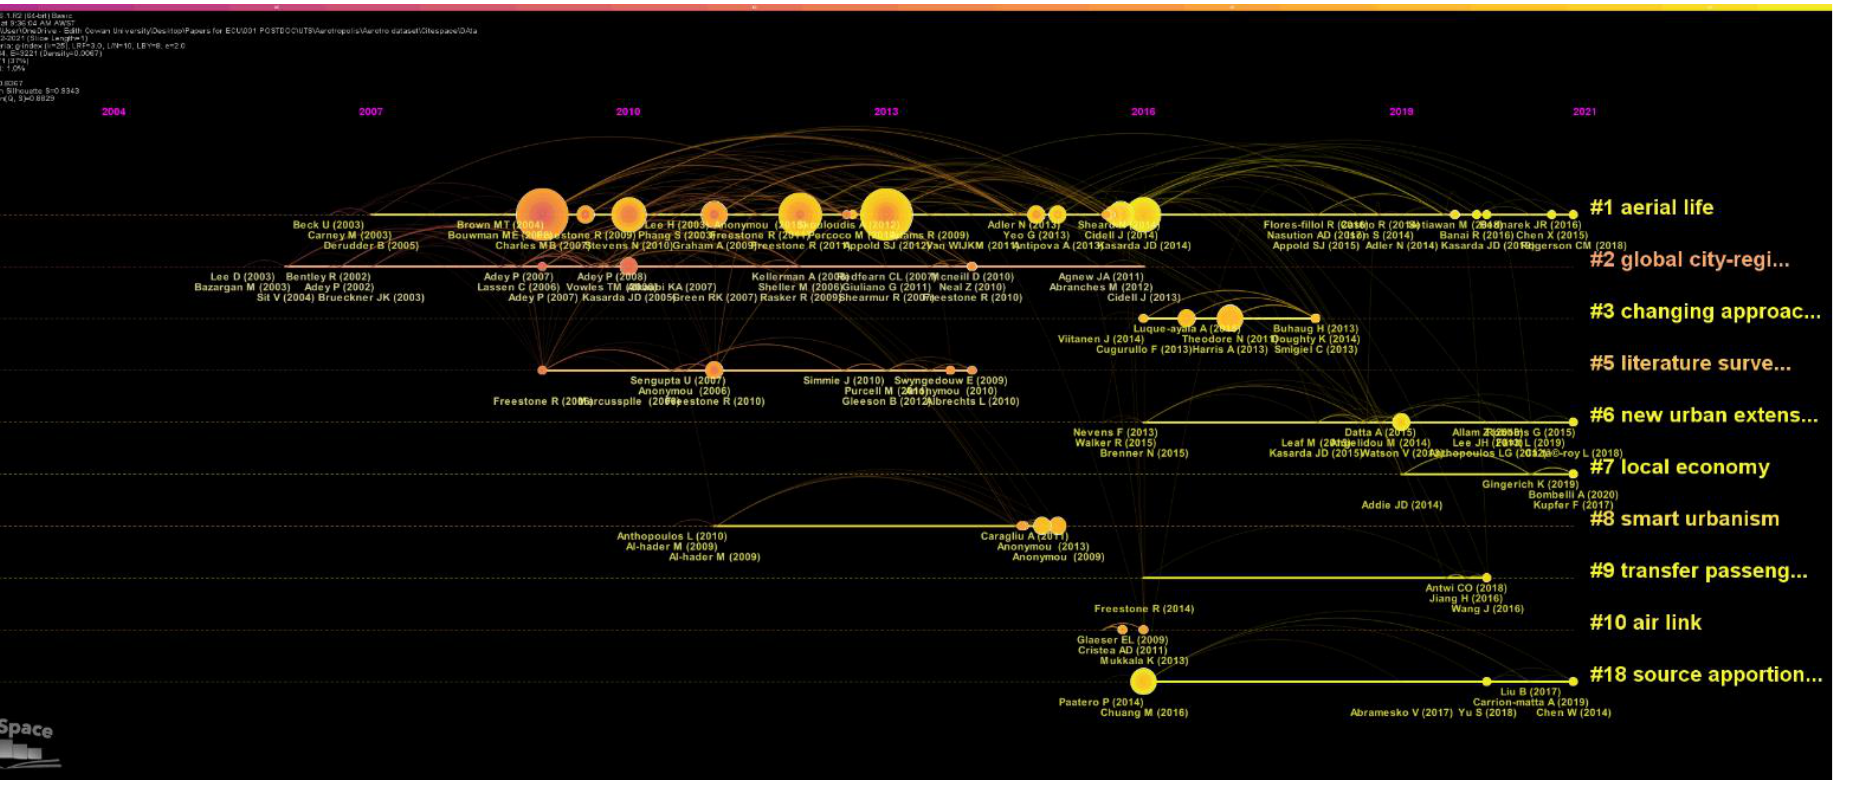
Figure 16 . Themes emanating from aerotropolis literature using CiteSpace software. Figure 16. Themes emanating from aerotropolis literature using CiteSpace